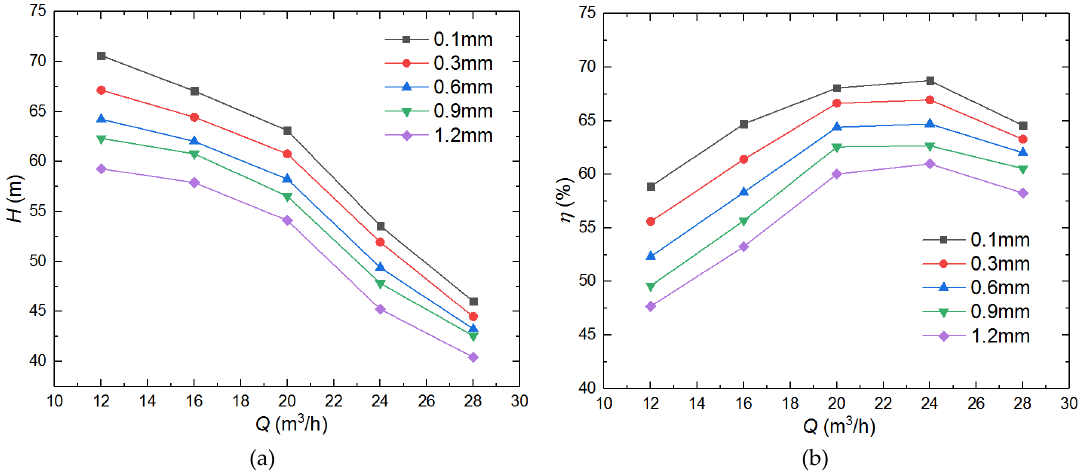
Figure 8. CFD-predicted performance with different end clearance size. ( a ) Head, ( b ) efficiency.